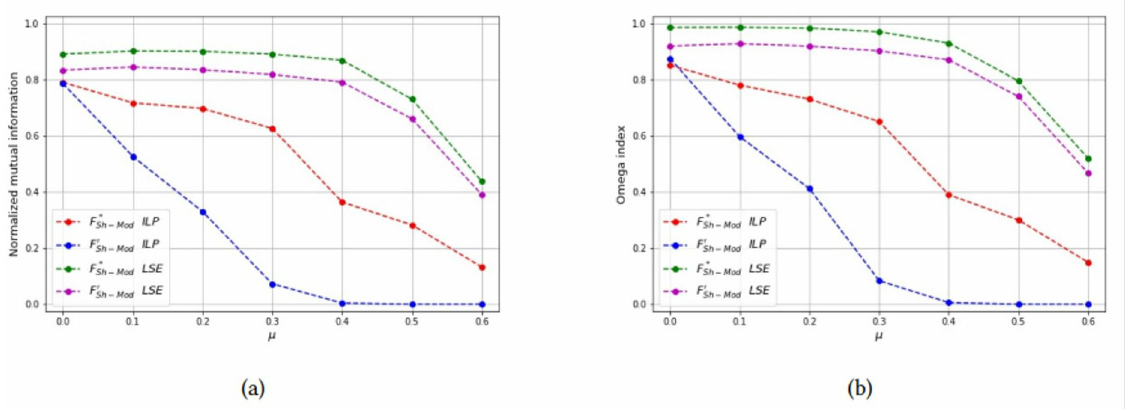
Fig 14. Test results on non-overlapping communities, parameters N = 60, n Omega for each solution method.